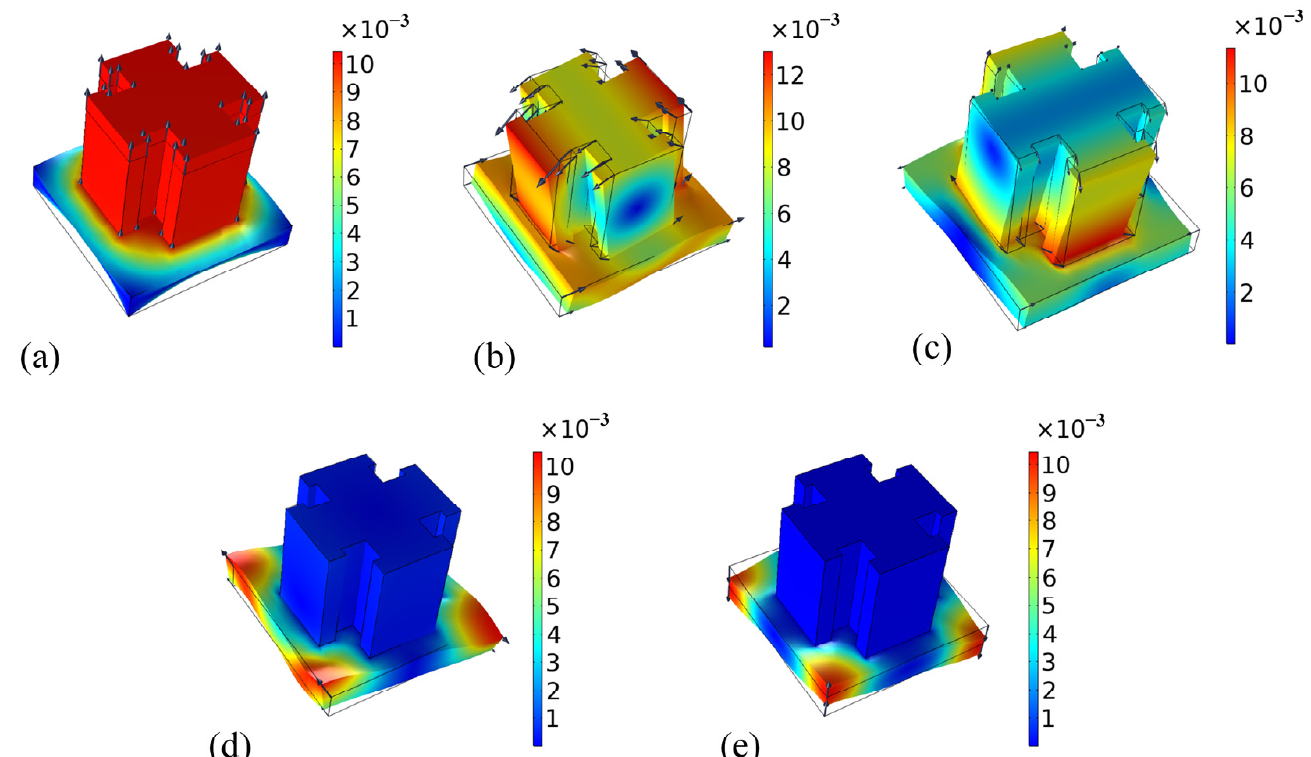
Figure 3. The displacement vector fields of the extracted intrinsic points in the energy band structure. ( a ) Mode A; ( b ) Mode B; ( c ) Mode C; ( d ) Mode D and ( e ) Mode E.